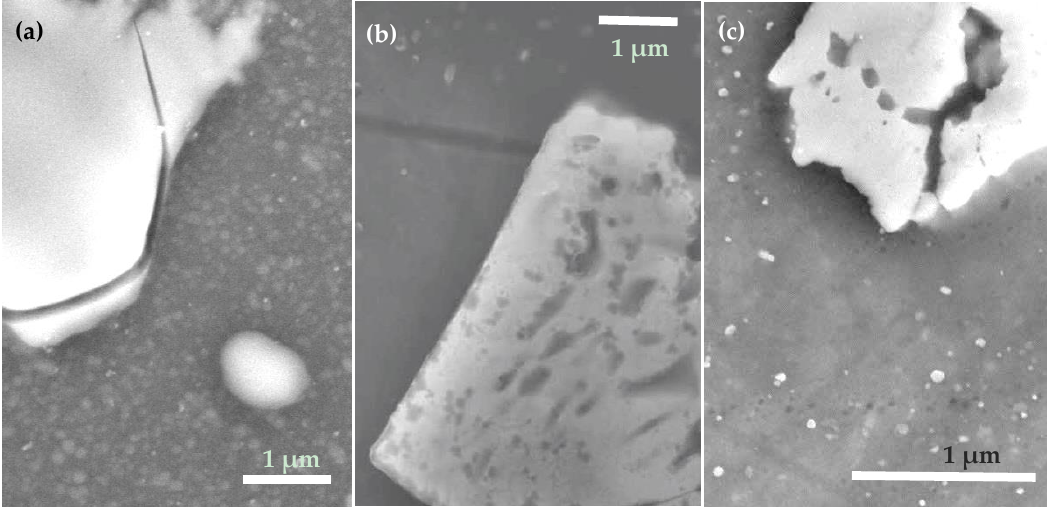
Figure 3. Surface SEM images of two-layer coatings: samples 4 ( a ), 5 ( b ), and 6 ( c ). All the surfaces are coated with ODTMS top-layer, with no traces of surface corrosion seen.